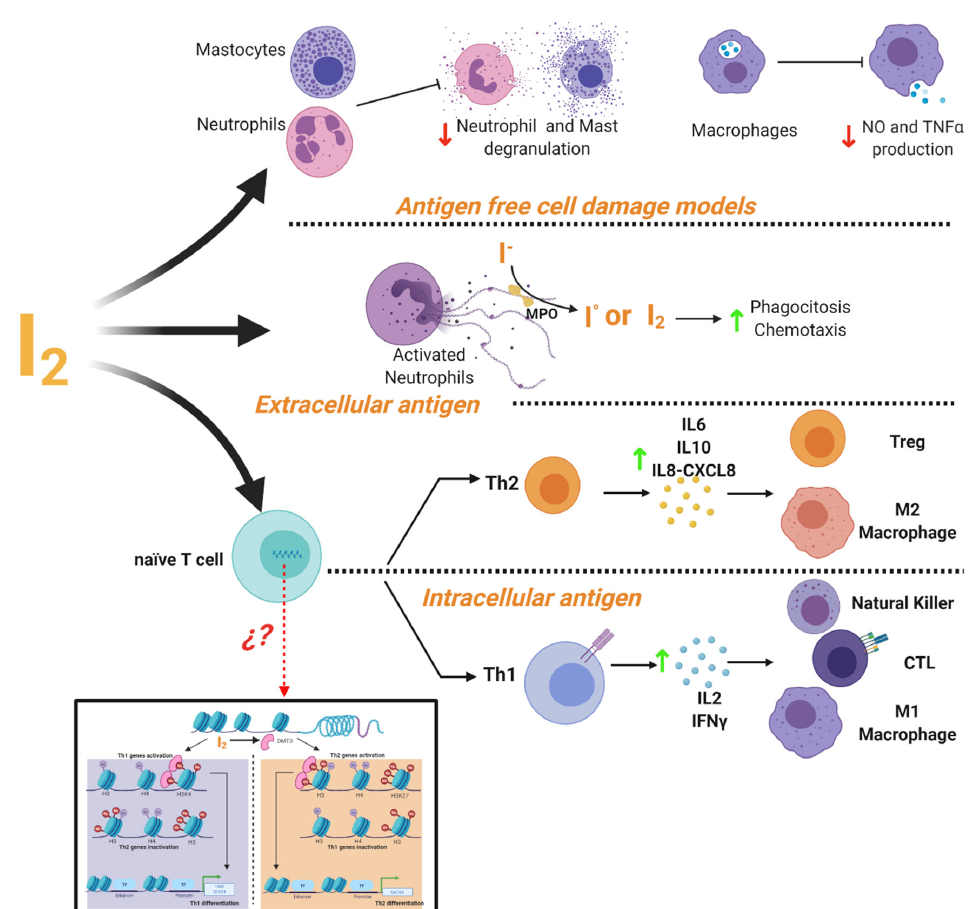
Figure 4. Mechanisms of immune modulation by molecular iodine (I 2 ). Evidence showed that I 2 the mediated activation or inhibition of immune responses depending on the cellular context. In a cell damage environment without antigens iodine supplementation inhibits the degranulation of neutrophil and mast cells, as well as the production of macrophages NO and TNF α . In response to extracellular antigens (e.g., bacteria or fungi), I 2 improves the phagocytosis and chemotaxis of activated neutrophils. It also activates the Th2 response and the increase of cytokine secretion (IL-6, IL-10, IL-8-CXCL8) promoting the activation and differentiation of Treg lymphocytes and M2 macrophages. In response to intracellular antigens (e.g., virus-infected cells and cancer cells), I 2 activates the Th1 response and increases the cytokine production of IL-2 and IFN γ , promoting the activation and proliferation of effector cells (NK, CTL and M1 macrophages). This differential response might be associated with epigenetic modifications facilitated by the I 2 -mediated activation of the demethylase enzyme (DMT3) that regulates the Th fate by activating and/or inactivating the specific genes for the differentiation of Th1 (T-bet and STAT4) or Th2